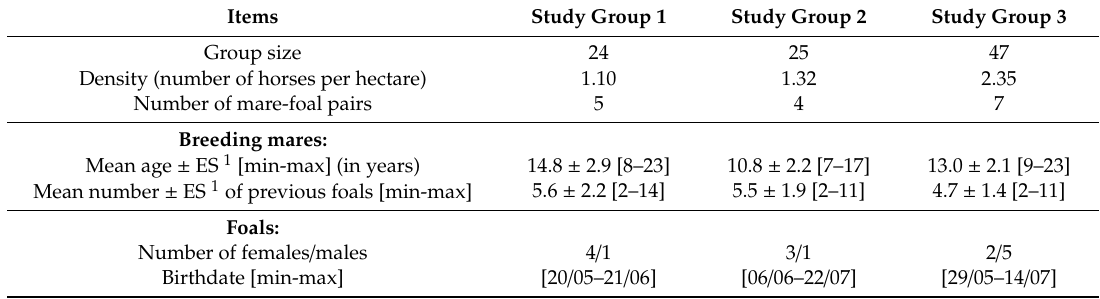
Table 1. Description of groups and mare–foal pairs: age and parity of mares; sex and birthdate of foals.